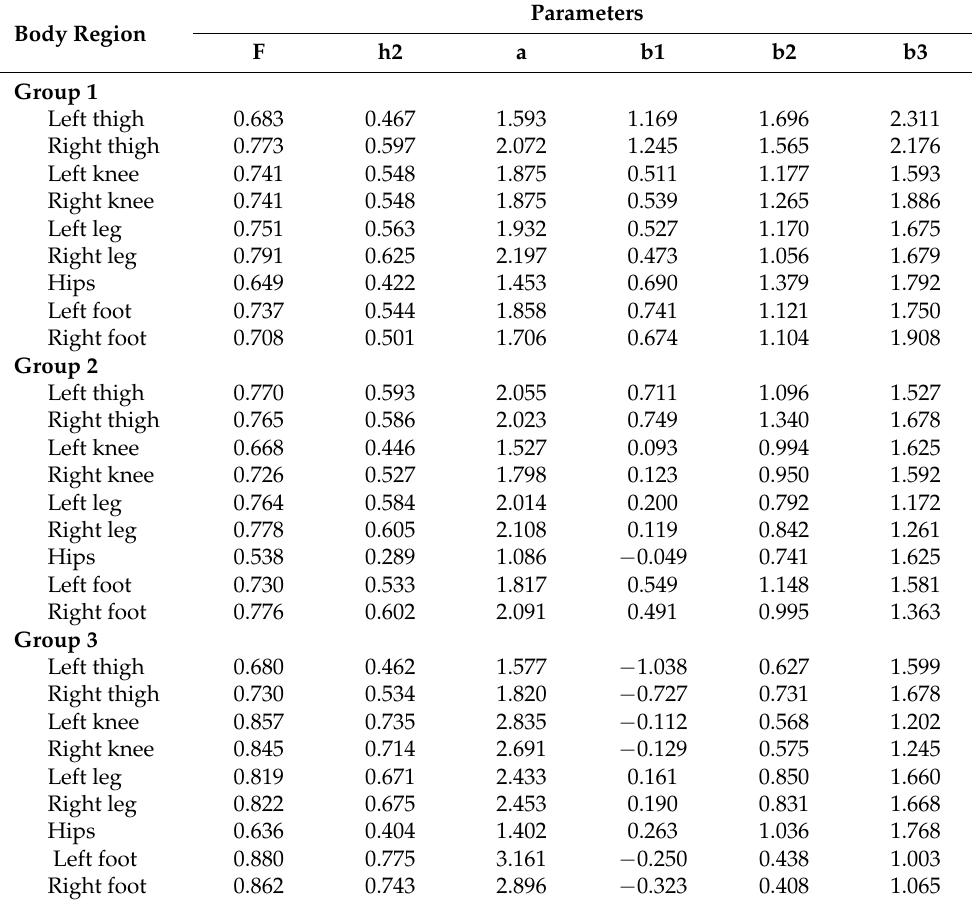
Table 3. Factor analysis and estimates of IRT